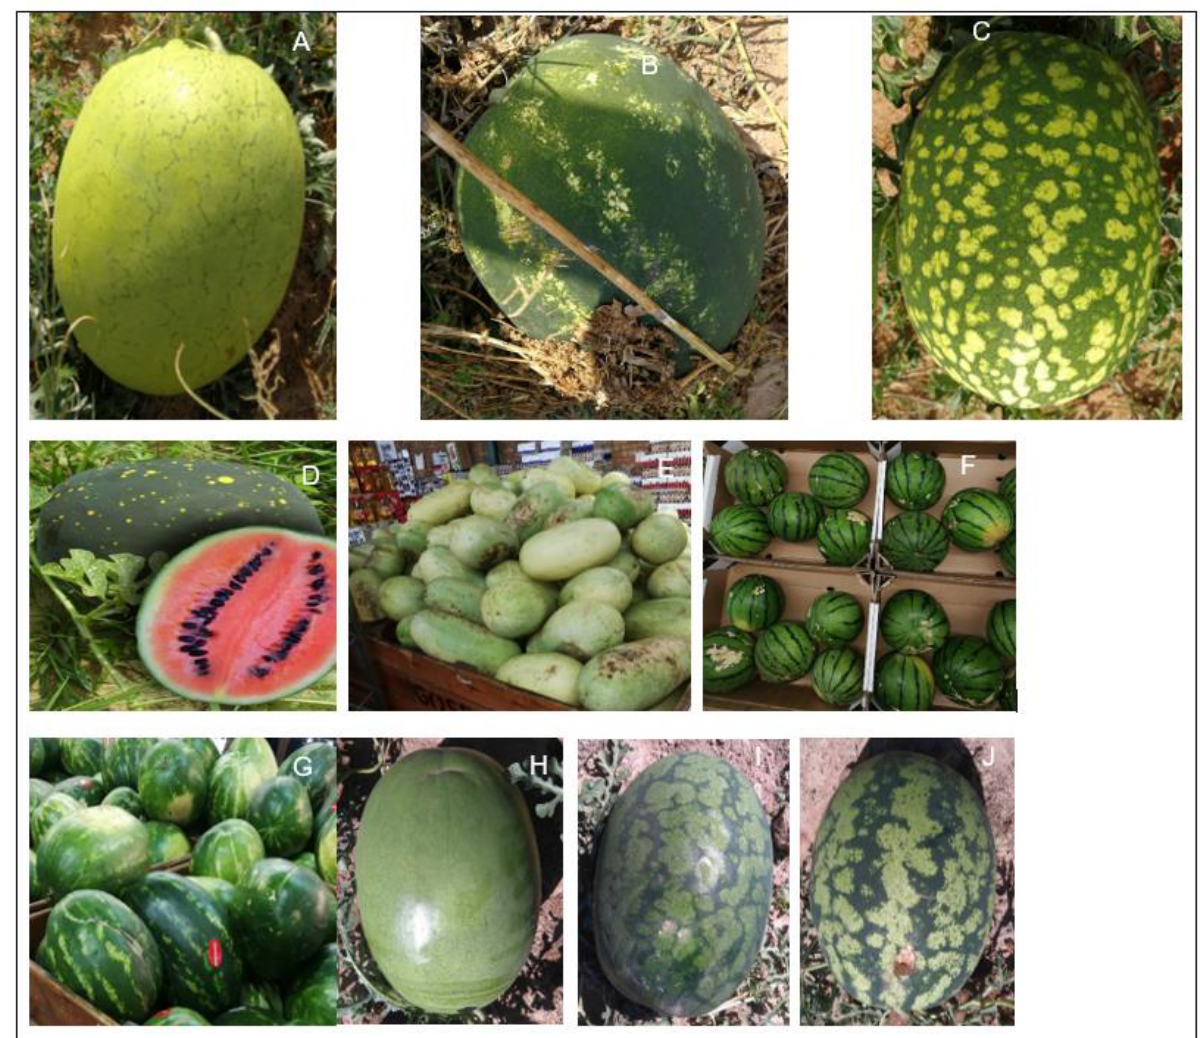
Figure 1. Fruit shape, colour and rind stripe patterns of sweet watermelon. ( A ); Round fruit with no distinctive stripes; ( B ), Round fruit with medium light-green rind stripes; ( C ), Light-green oblong fruit with no distintive rind stripes; ( D ), Moon and star trait on fruit (source: http://www.starkeayres.co.za (accessed on 15 April 2022); ( E ), Light-green elongated fruit; ( F ), Round fruit with dark-green and thin rind stripes; ( G ), Dark-green fruit with light-green rind stripes; ( H ), Medium-green elongated fruit with no stripes; ( I , J ), Medium-green oblong fruit with dark-green rind stripes (Photographs except ( G ) by J.